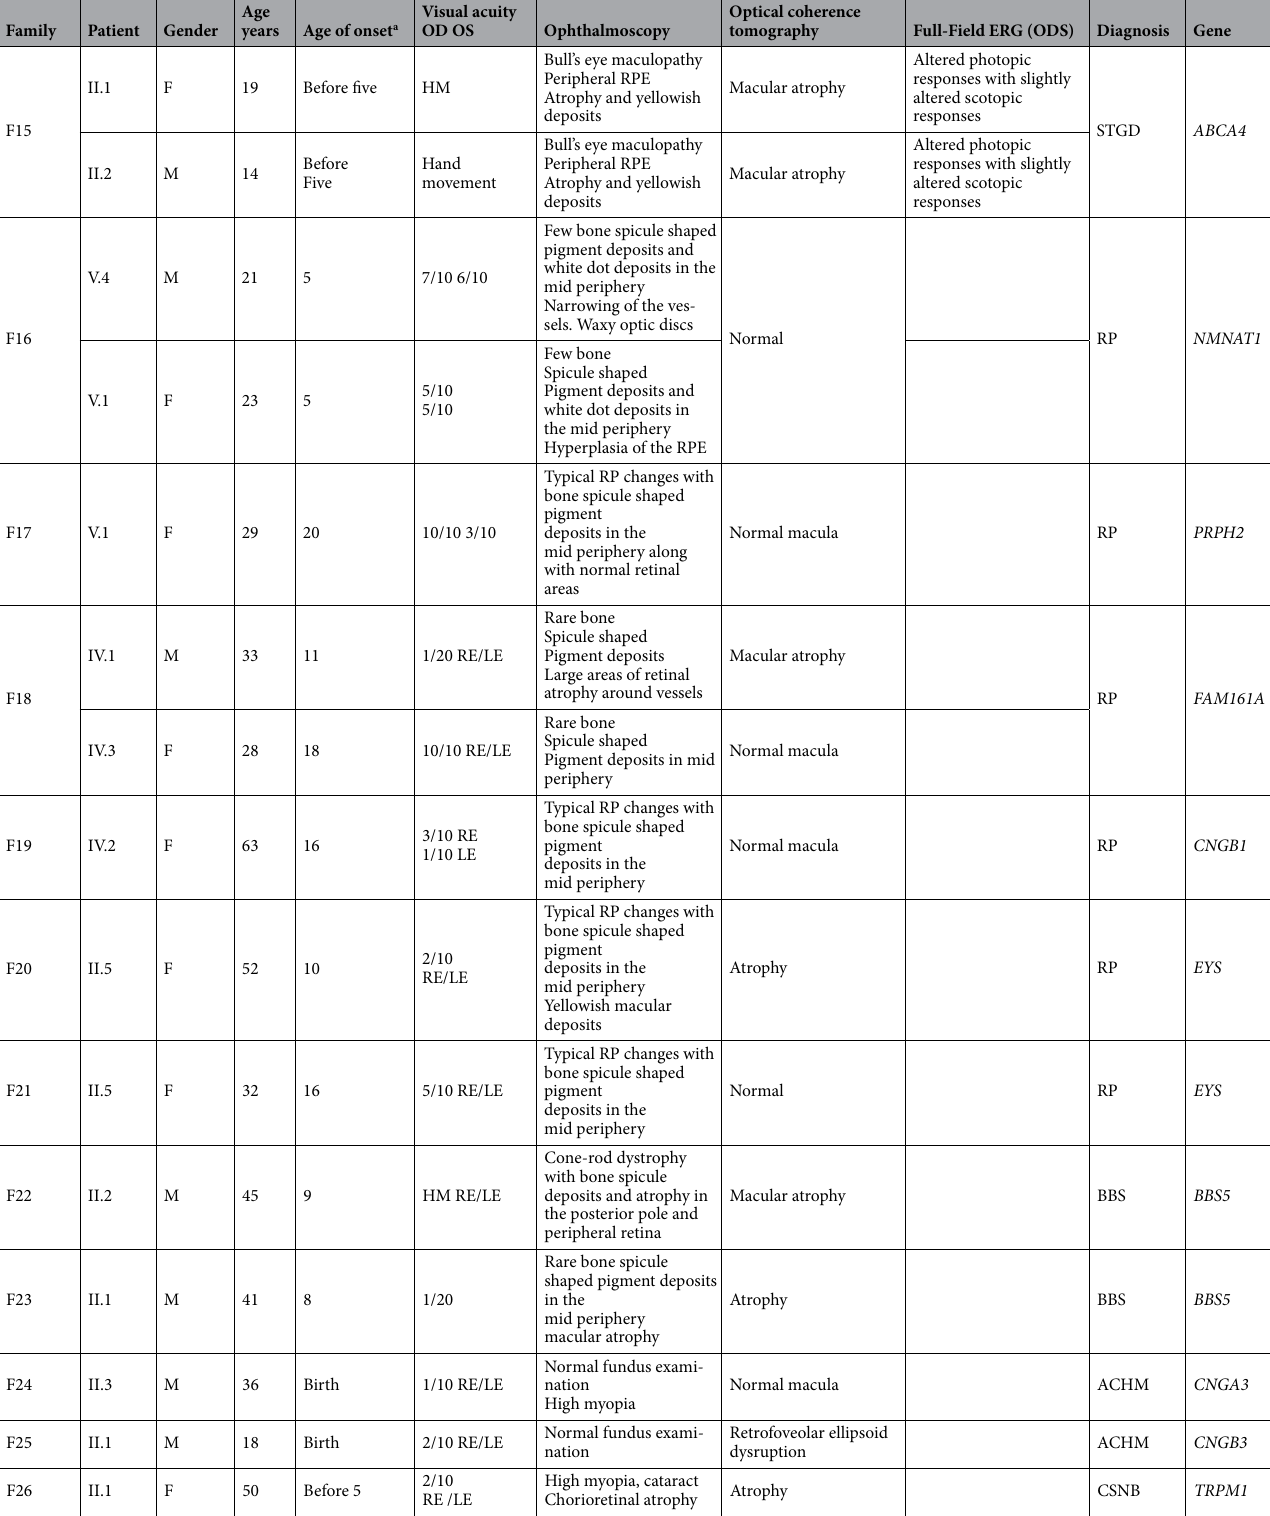
Table 2. Summary of the clinical data of 26 families with gene-associated retinal dystrophies. CF = counting fingers; HM = hand movements; LP = light perception; HM: hand movement. RE = right eye; LE = Left